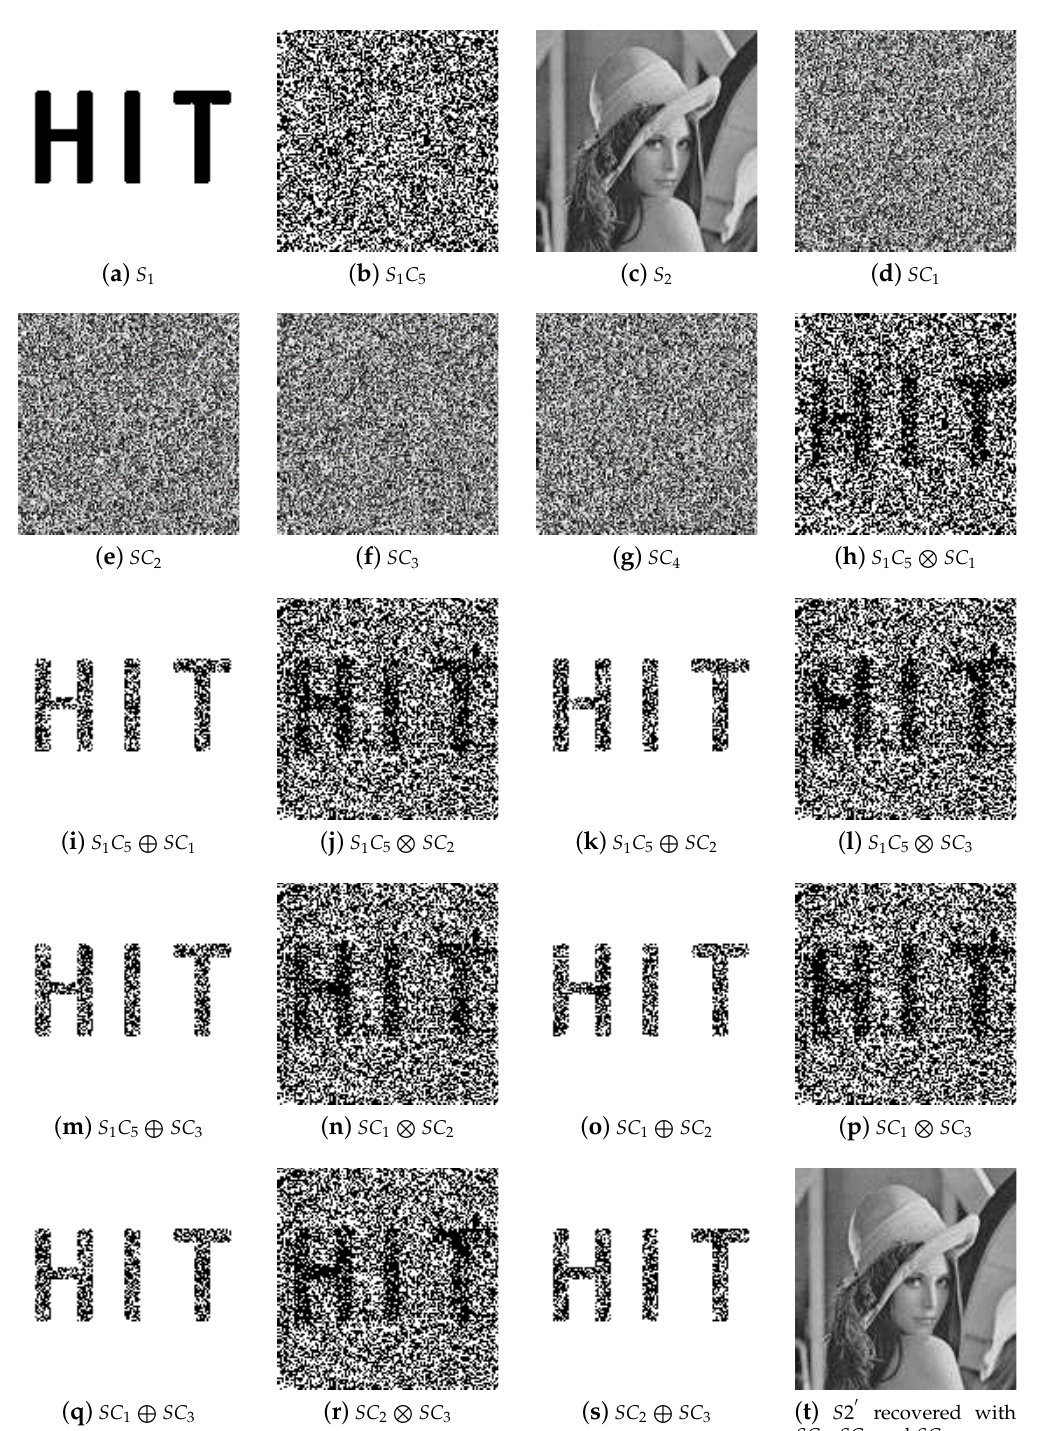
Figure 5. Experimental results of ( 3,4 ) threshold SIS authentication with dealer-participatory and non-dealer-participatory mutual shadow authentication capabilities. ( a ) The binary authentication image S 1 ; ( b ) the binary authentication shadow S 1 C 5 ; ( c ) the grayscale secret image S 2 ; ( d – g ) four grayscale shadows SC 1 , SC 2 , SC 3 and SC 4 ; ( h – m ) recovered binary authentication image with S 1 C 5 and the LSBs of SC 1 , SC 2 and SC 3 by stacking and XORing; ( n – s ) recovered binary authentication image with the LSBs of SC 1 , SC 2 and SC 3 by stacking and XORing; ( t ) recovered grayscale secret image S 2 (cid:48) with SC 1 , SC 2 and SC 3